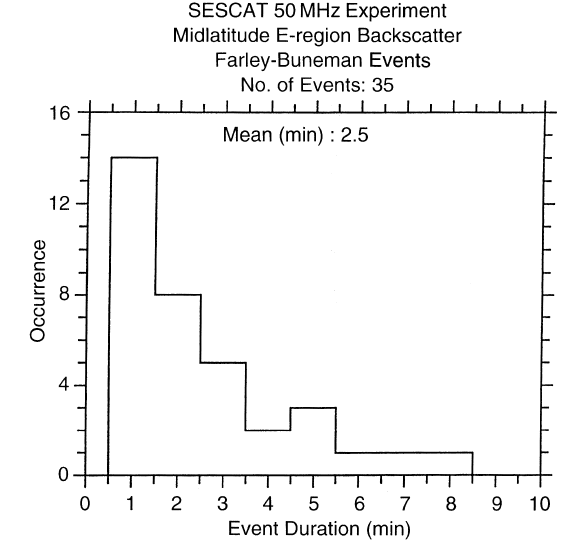
Fig. 6 . The distribution of mid-latitude type-1 echo duration based on many events detected by SESCAT. The mean echo lifetime is about 2.5 min